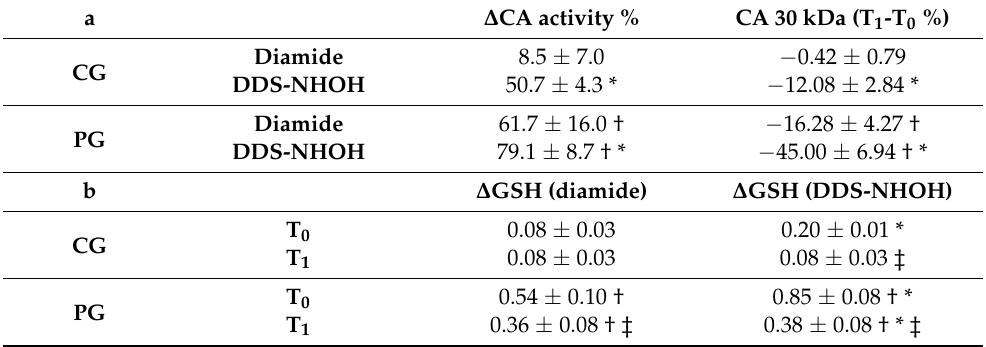
Table 1. The effect of 1-week licorice intake on CA activity and monomerization and ∆ GSH in the cytosol of RBCs, in the presence of diamide or DDS-NHOH in in vitro treatment. Panel a : CA activity and monomerization values, obtained at T 0 and T 1 , were expressed as the decrease after licorice intake, in the absence (basal), or presence of DDS-NHOH. The activity of CA was assayed in the RBC cytosol as described in the Methods. The decrease following the licorice intake ( ∆ CA activity %) was calculated as: (1-activity T 1 / activity T 0 )%. The monomerization of CA was assayed in diluted cytosol from 1 µ L of packed RBCs, obtained as described in the Methods. The cytosol underwent Western blotting in non-reducing conditions and was immunostained with an anti-CA antibody. Densitometrical analysis of the CA bands was carried out and the sum of the 30 and 60 kDa bands was arbitrarily calculated as 100%, taking into account that amount of proteolytic 30 kDa bands accounts for half the larger [36]. Panel b : Total glutathione was determined according to the Tietze method [4], as described in the Methods. The total decrease of glutathione content after diamide or DDS-NHOH treatment ( ∆ GSH) was expressed as 1-GSH(Diam or DDS-NHOH)/GSH(Basal) [4,36]. a ∆ CA activity % CA 30 kDa (T 1 -T 0 %) Diamide 8.5 ± 7.0 − 0.42 ± 0.79 CG DDS-NHOH 50.7 ± 4.3 * − 12.08 ± 2.84 * Diamide 61.7 ± 16.0 † − 16.28 ± 4.27 † PG DDS-NHOH 79.1 ± 8.7 † * − 45.00 ± 6.94 † * b ∆ GSH (diamide) ∆ GSH (DDS-NHOH) T 0 0.08 ± 0.03 0.20 ± 0.01 * CG T 1 0.08 ± 0.03 0.08 ± 0.03 ‡ T 0 0.54 ± 0.10 † 0.85 ± 0.08 † * PG T 1 0.36 ± 0.08 † ‡ 0.38 ± 0.08 † * ‡ Values are expressed as the mean ± SD of n = 12 healthy subjects (CG) and n = 18 patients (PG). Comparison from respective basal values: * p < 0.005, Student’s t -test for paired data. Comparison CG vs. PG: † p < 0.001, Student’s t -test for unpaired data. Comparison between T 0 and T 1 within each group: ‡ p < 0.001, Student’s t -test for paired